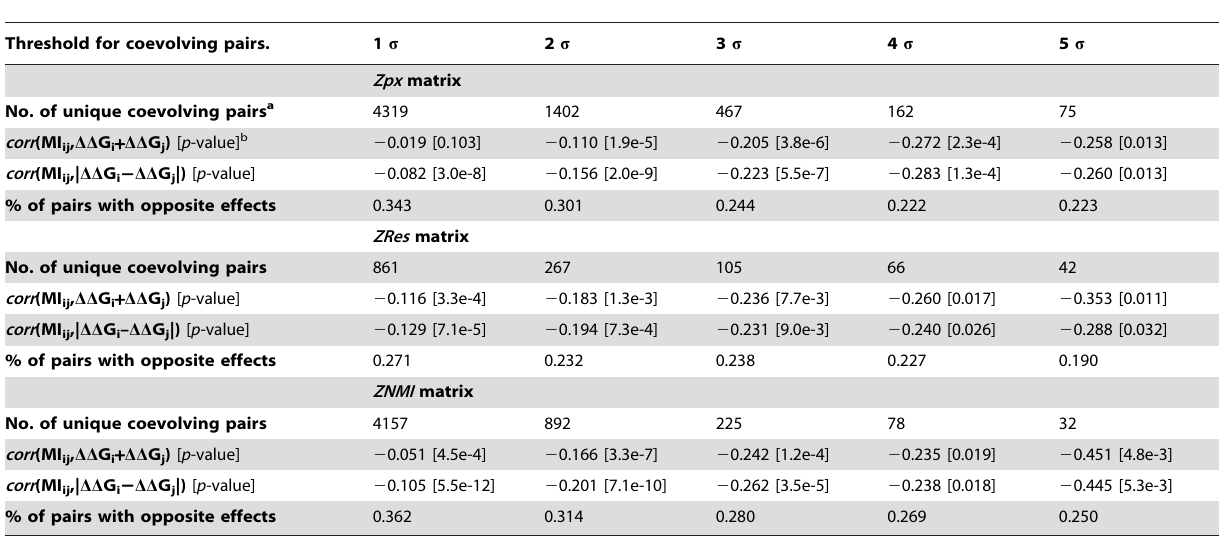
Table 3. Correlation coefficients between the vectors of MI scores for i,j pairs above a threshold s value and the vectors representing the average effect of those pairs on the stability of KDO8PS.